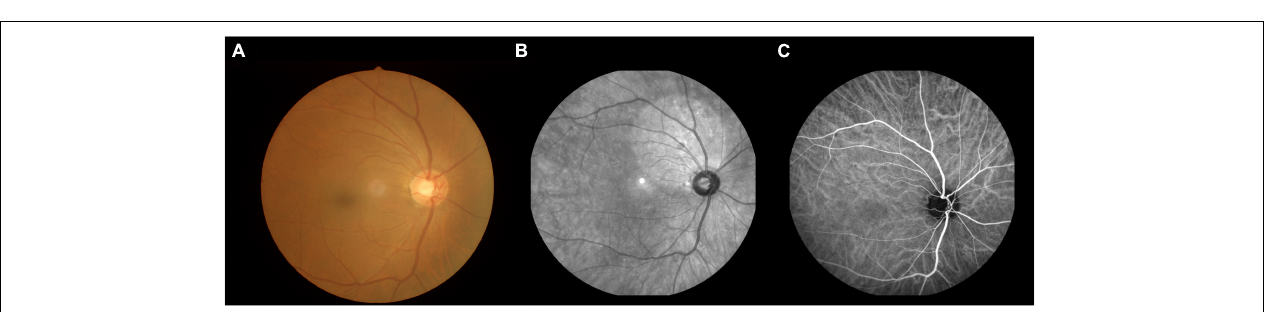
Frontiers in Aging Neuroscience |